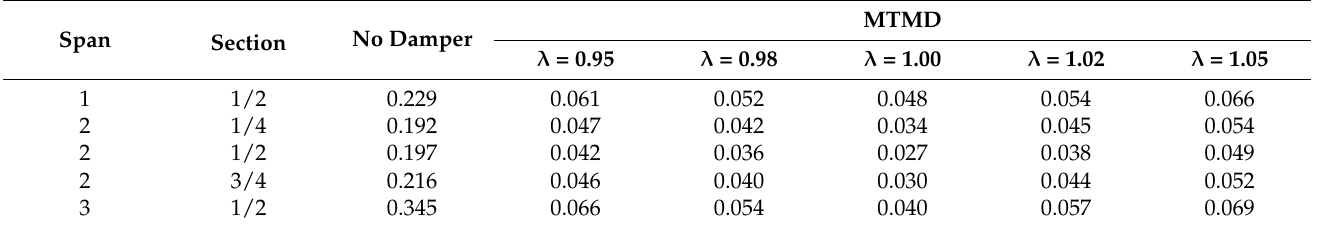
Table 10. Effect of the center frequency ratio on the lateral acceleration of the bridge.